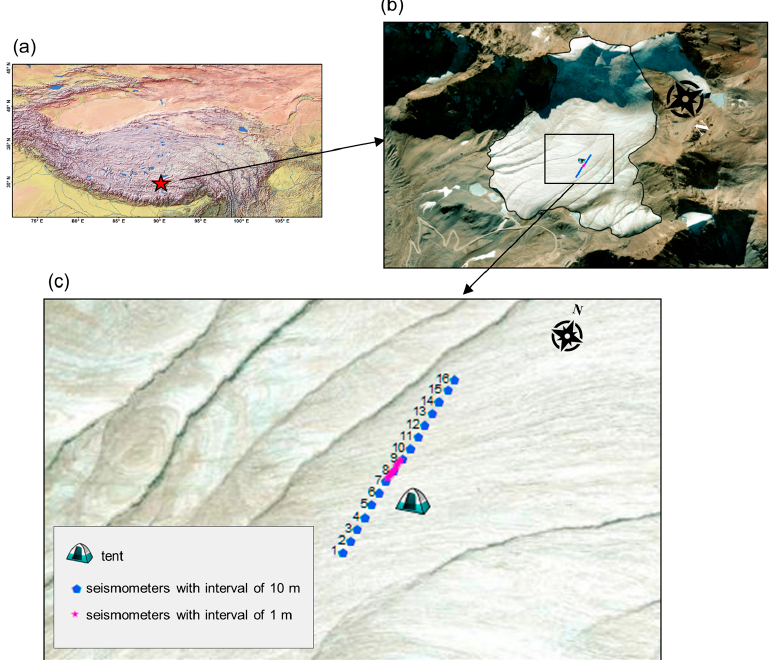
Figure 1. The installed FOSA consisting of 16 seismometers on the KQGR Glacier in the TP. ( a ) The study area. The red star marks the location of the KQGR Glacier. ( b ) The KQGR Glacier. The black box shows the location of the installed seismometers. ( c ) The installed 16 seismometers. The blue and pink pentagons are the seismometers with intervals of 10 m and 1 m, respectively.